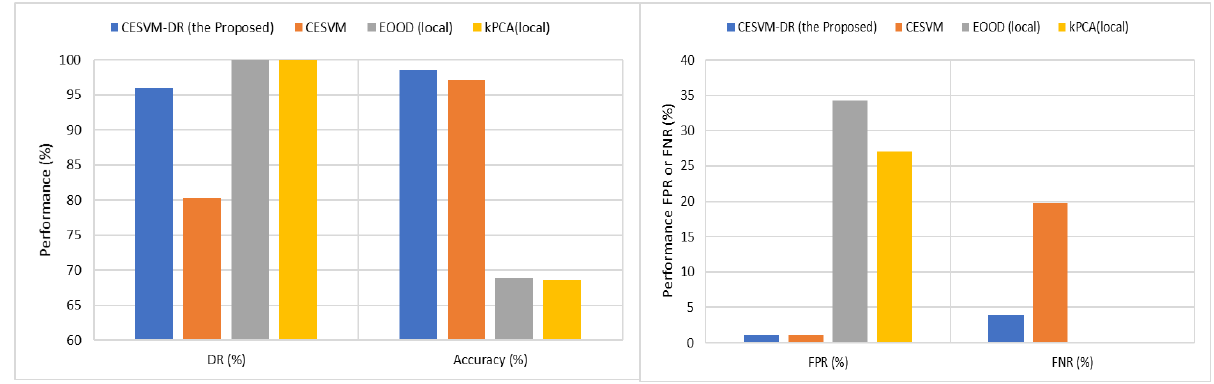
Figure 6. Average Performance Comparisons Accuracy and DR ( left ) while FPR and FNR ( right ).